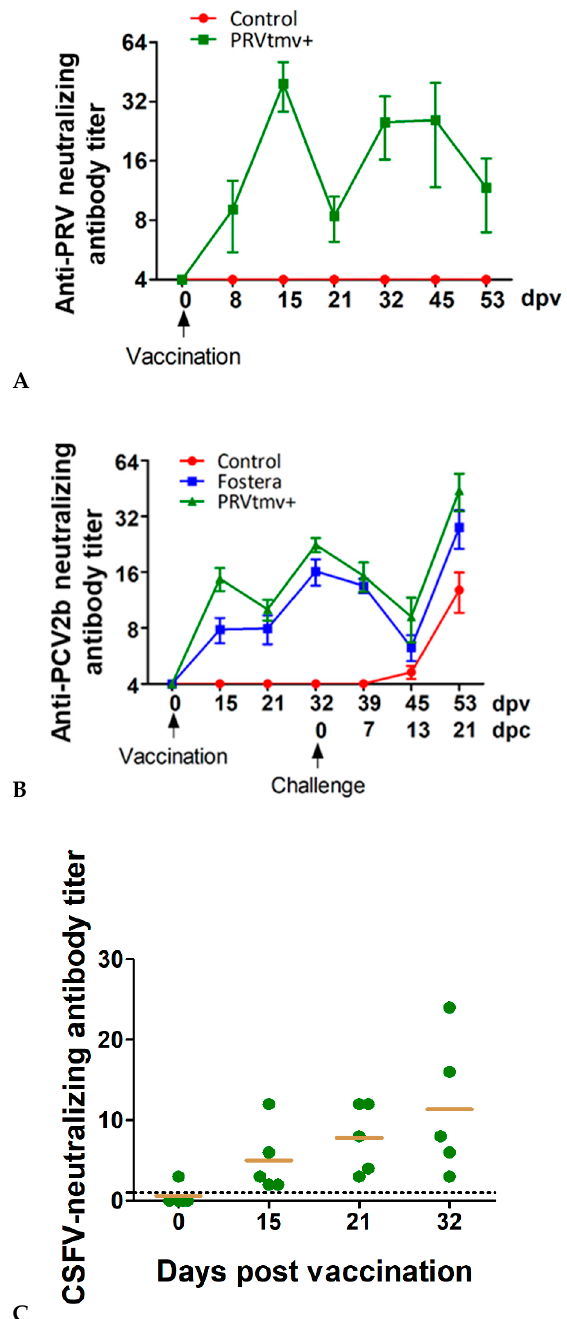
Figure 13. PRV-, PCV2b-, and CSFV-specific serum neutralizing (SN) antibody titer developed in pigs after PRVtmv+ vaccination. ( A ) PRV-specific SN titers. The data represent the mean + standard deviation ( n = 5). ( B ) PCV2b-specific SN antibody titer following PRVtmv+ immunization and PCV2b challenge. PCV2b is non-cytopathic, and the viral plaques were visualized by IFA at 72 h post-inoculation using the PCV2b specific mAbs 36F1 and fluorescent-tagged secondary antibody. ( C ) CSFV-specific neutralization dose (ND 50 ) SN titers following PRVtmv+ immunization. ND 50 titers were calculated as described earlier [51] and briefly in the materials and method section. The dot plot graph shows each animal’s mean values and individual titer with standard deviation ( n = 5). dpv—days post ‐ vaccination; dpc—days post ‐ challenge. 3.9. PRVtmv+ Immunized Pigs Generated CSFV ‐ Specific Neutralizing Antibody Titers